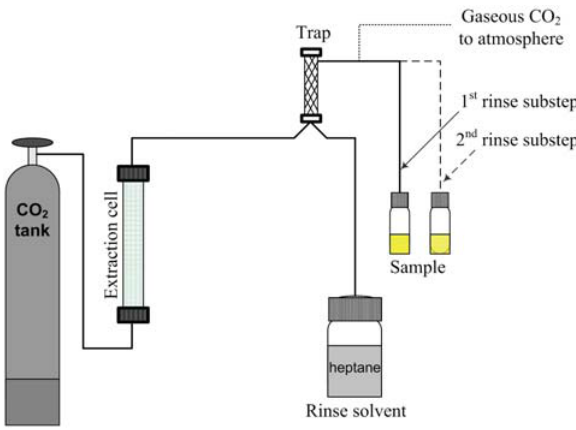
Figure 1 . Schematic diagram of supercritical fluid